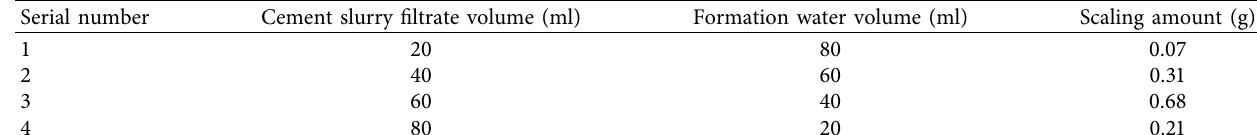
Table 4: Compatibility test results of cement slurry fltrate and formation water.